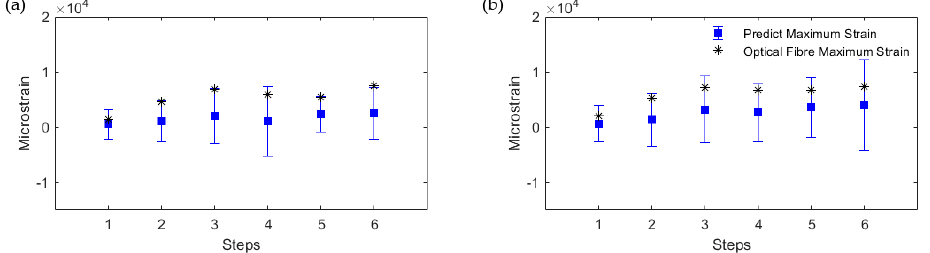
Figure 21. OOP deformation test Step 1 to Step 6: Predicted maximum strain with 95% of certainty along the vertical line ( a ) at 800 mm and ( b ) at 1000 mm horizontally compared with optical fibre maximum strain measurements.